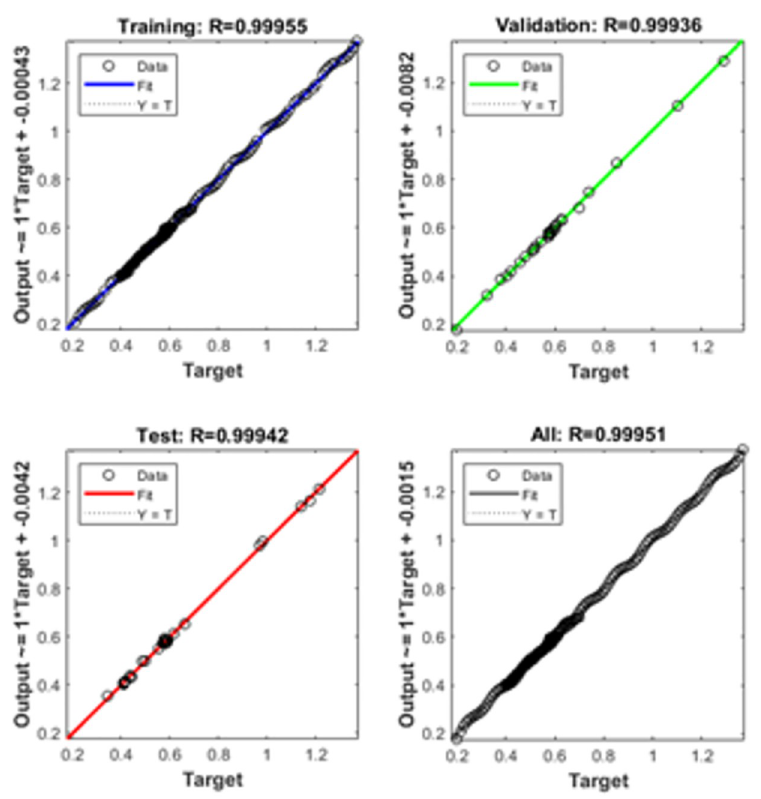
Fig 8. Regression actions for solving the infection FONPPS of Case 3.